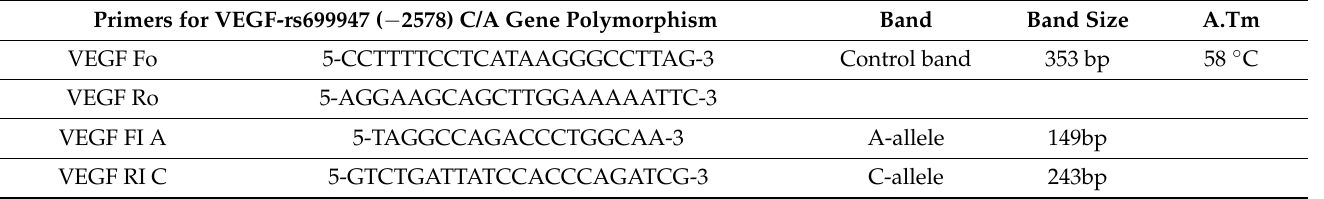
Table 1. Genotyping primers of gene